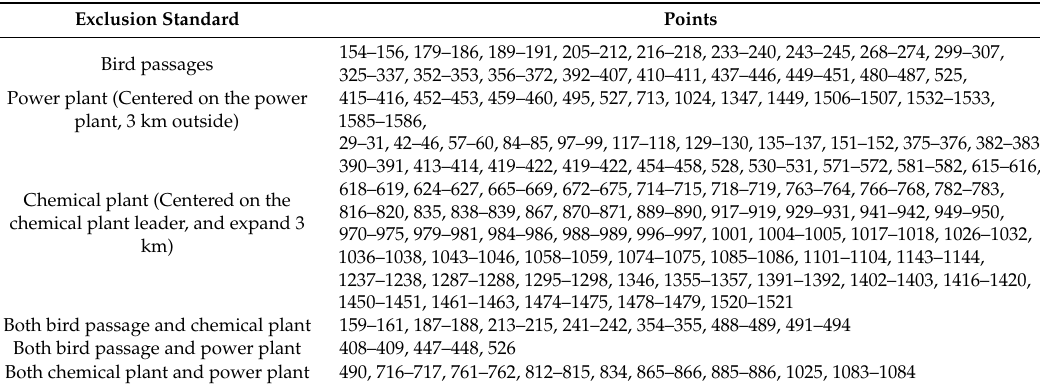
Figure 3. Grid partition of candidate region. Table 1. Points and reasons for exclusion.